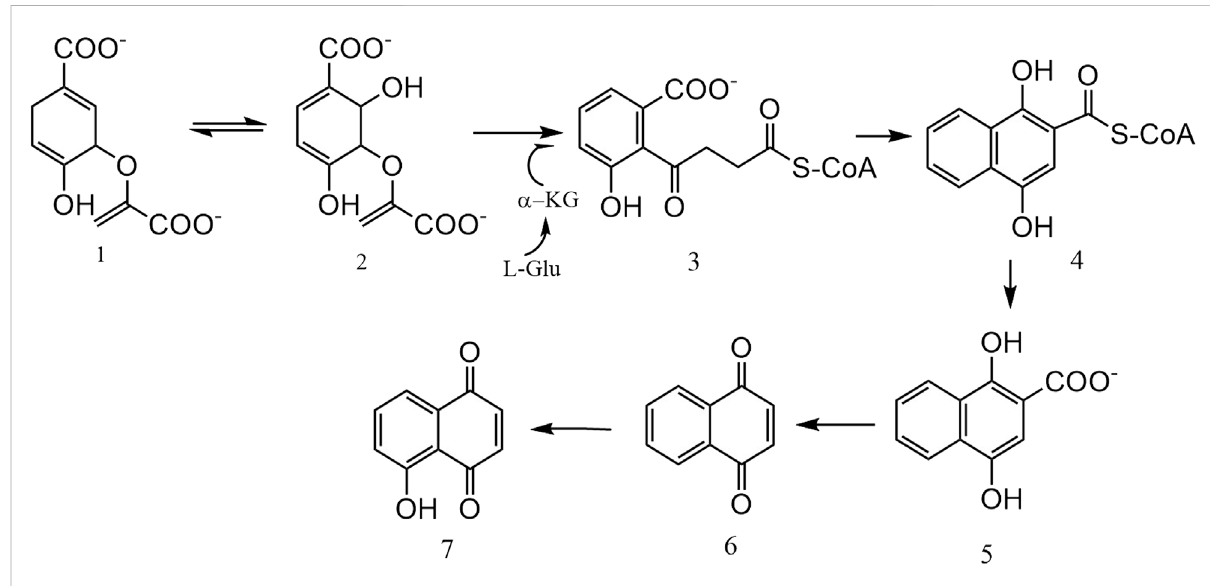
FIGURE 2 Biosynthetic pathway of juglone in walnut (McCoy et al.,